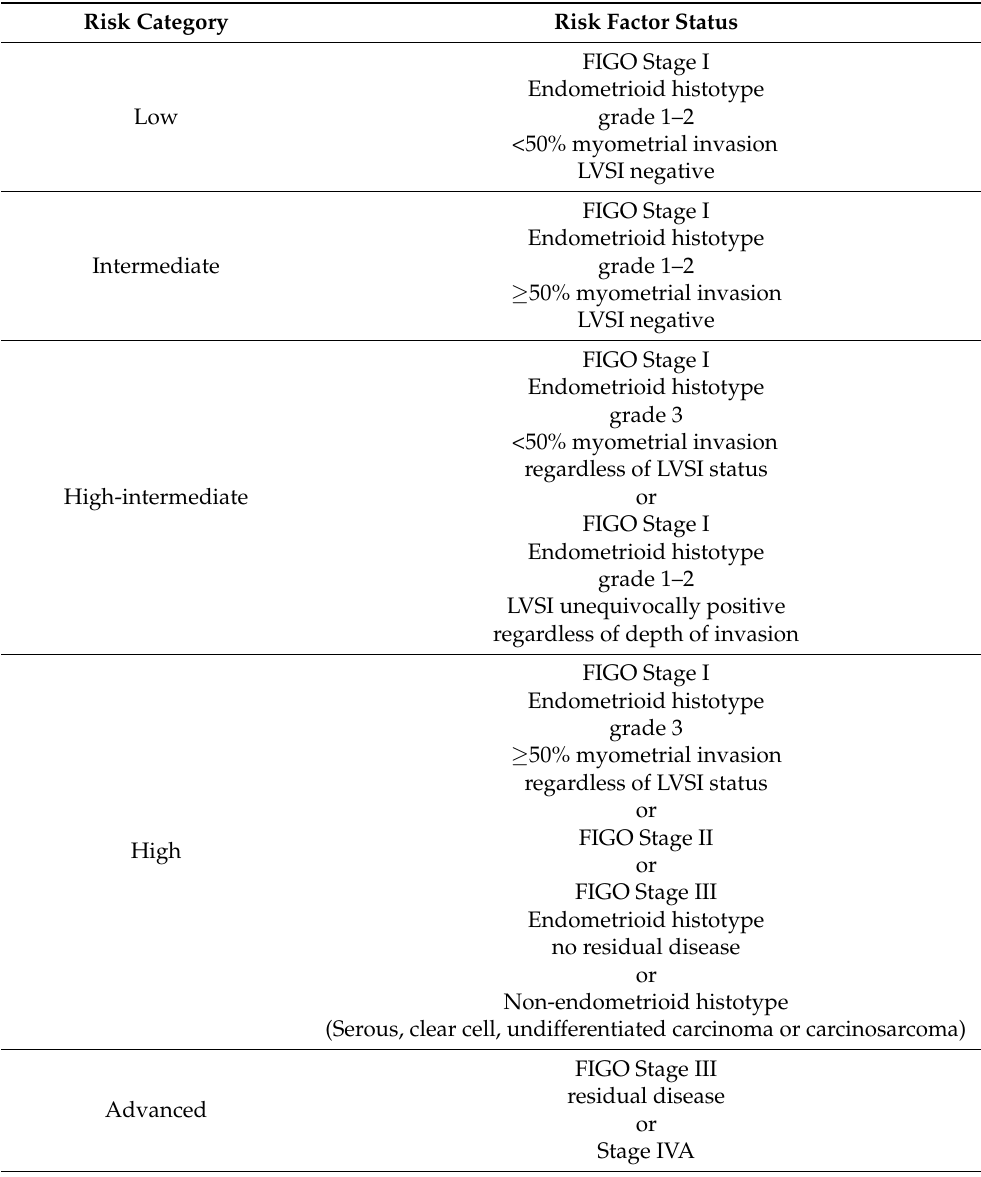
Table 1. Endometrial cancer ESMO/ESGO/ESTRO classification system, by Colombo et al. 2016